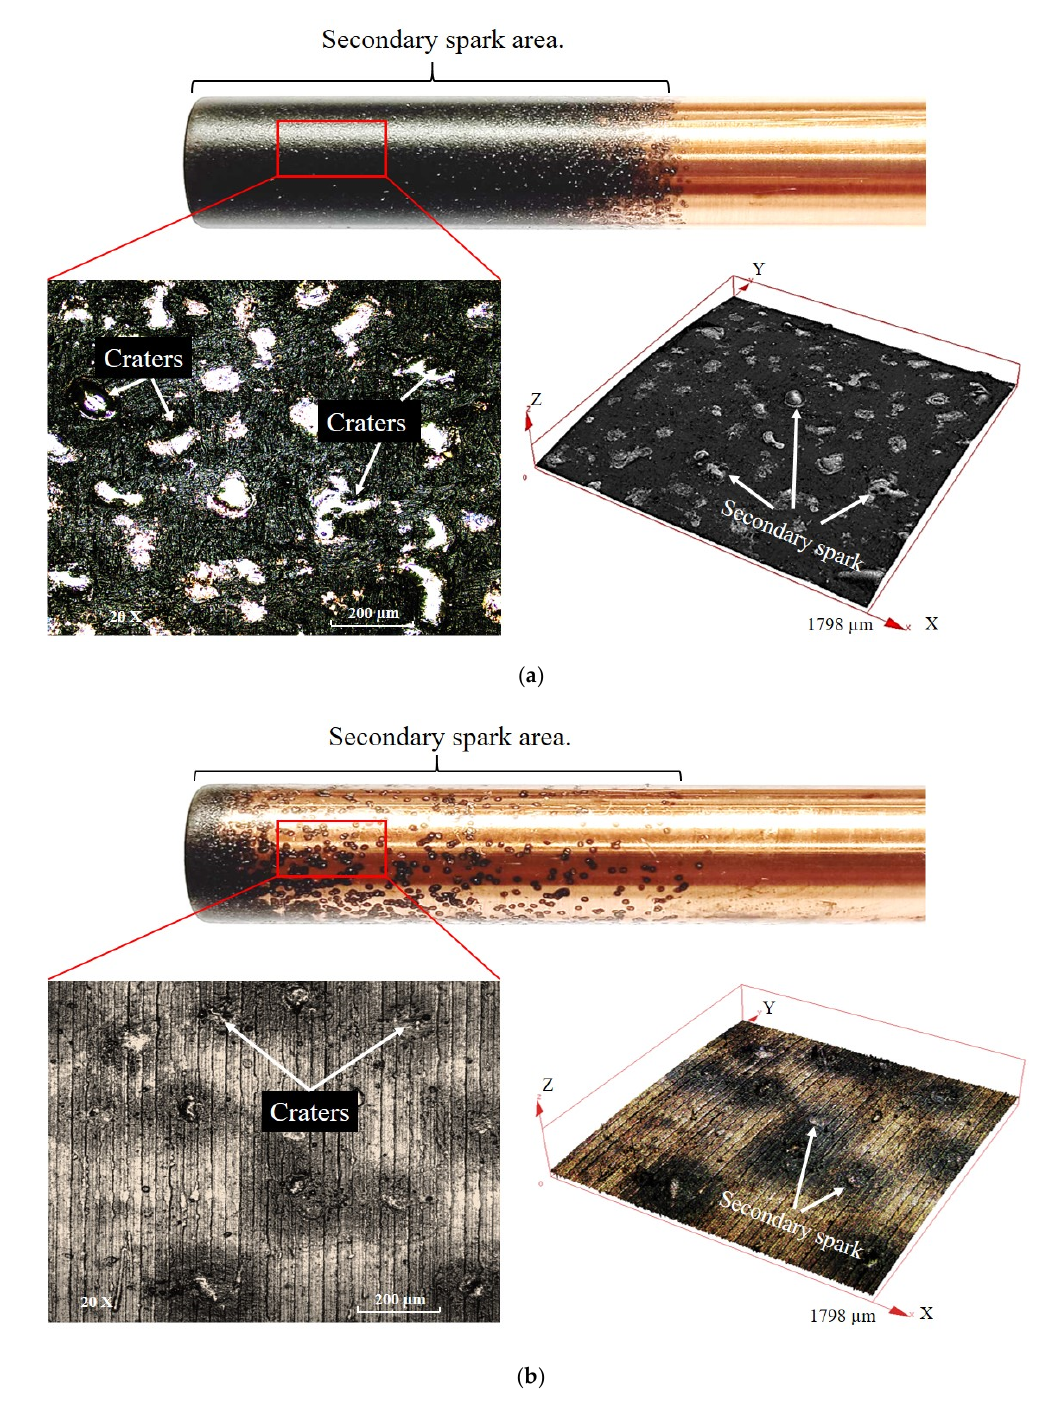
Figure 12. Craters and secondary sparks on the electrode: ( a ) EDM with side flushing, ( b ) EDM with multi-aperture